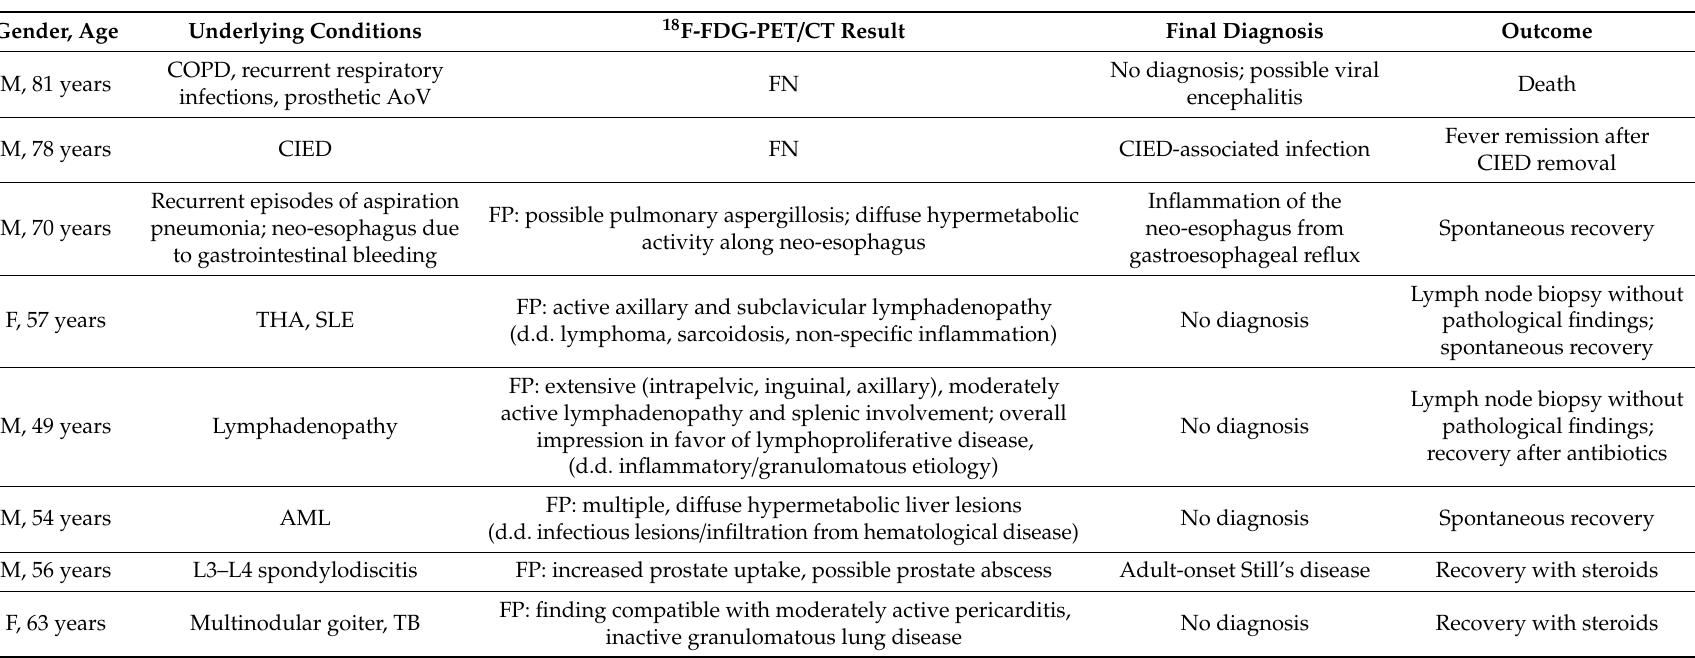
Table 5. Final diagnosis in patients with false positive or false negative 18 F-FDG-PET / CT